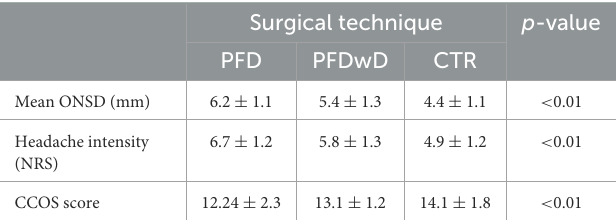
scores between groups after 3 different surgical approaches. Surgical